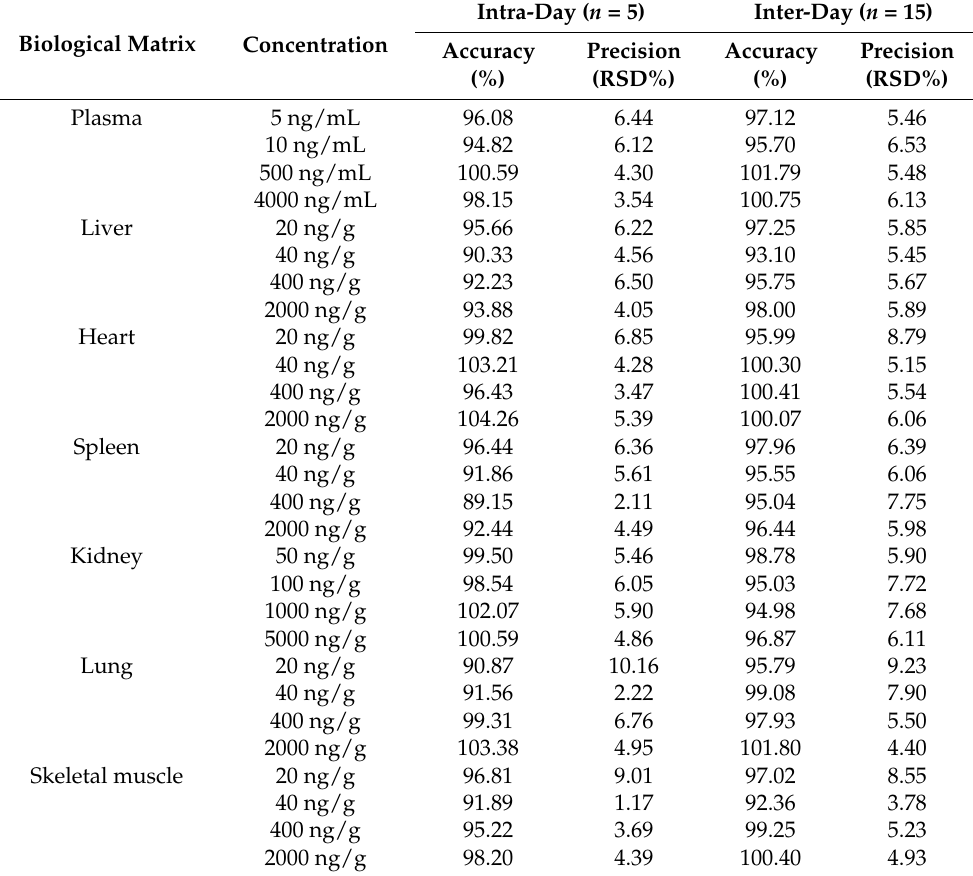
Table 2. The precision and accuracy for doxorubicin in rat plasma and six tissues.